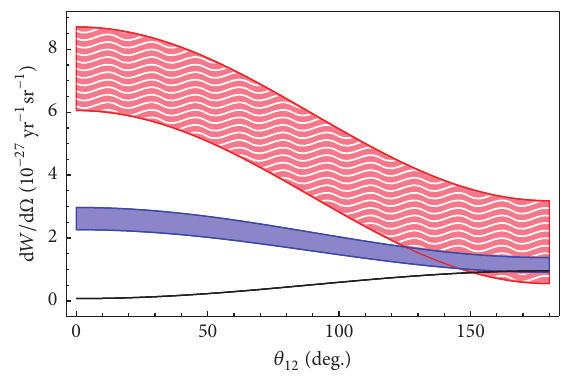
Figure 3: Same as Figure 2 for 130 Te.